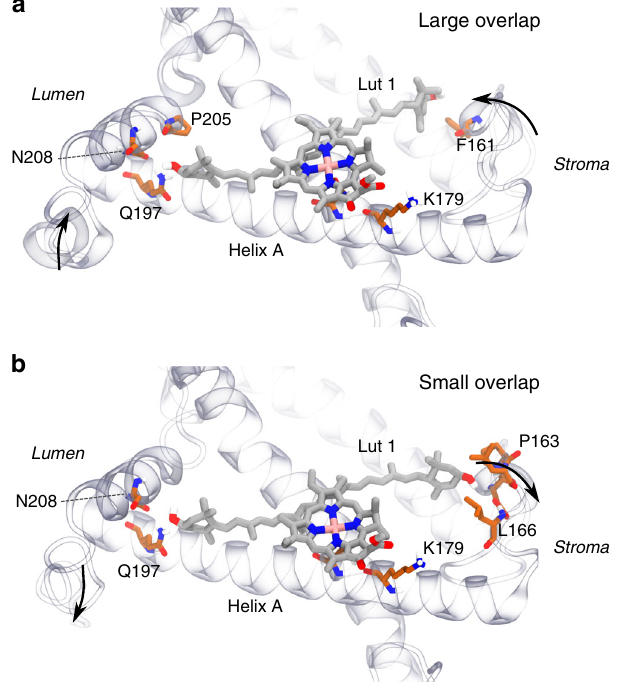
Fig. 5 Arrangement of the L1 site in extreme overlap con fi gurations. a Large overlap and ( b ) small overlap. The overlap values are, respectively, 9.8×10 − 2 and 4.7×10 − 2 Å 3 . The residues close to the terminal rings of Lut are shown for each case; residue names are given in the one-letter code. The arrows show the movement of the stromal loop with respect to the L1